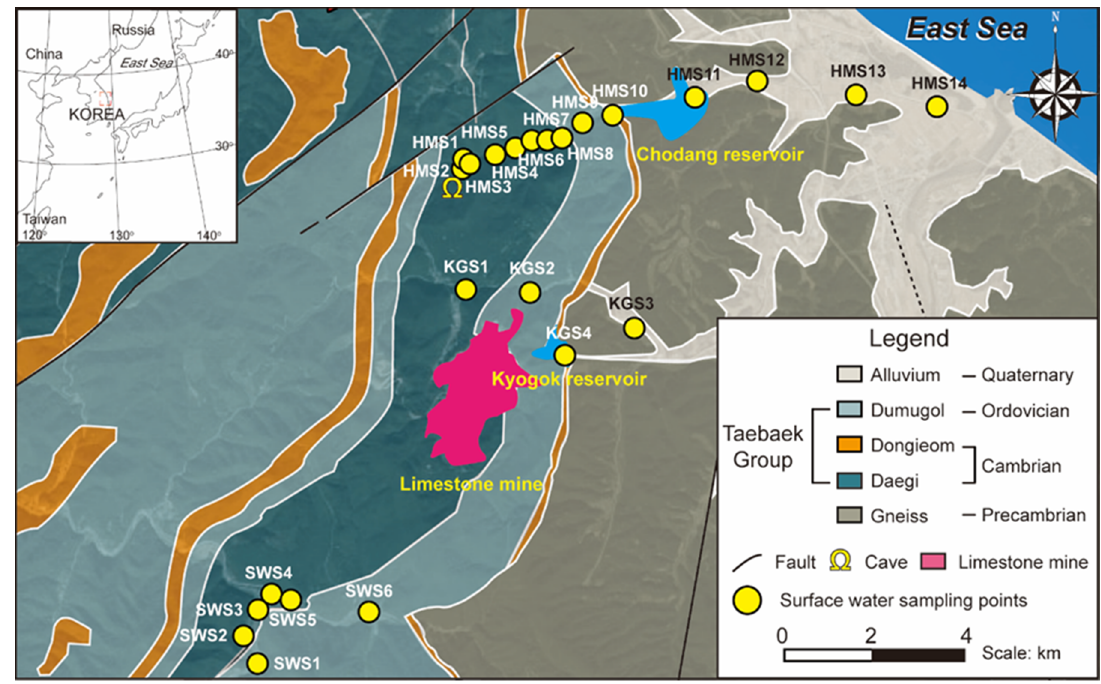
Figure 1. Geologic setting of the study area and sampling